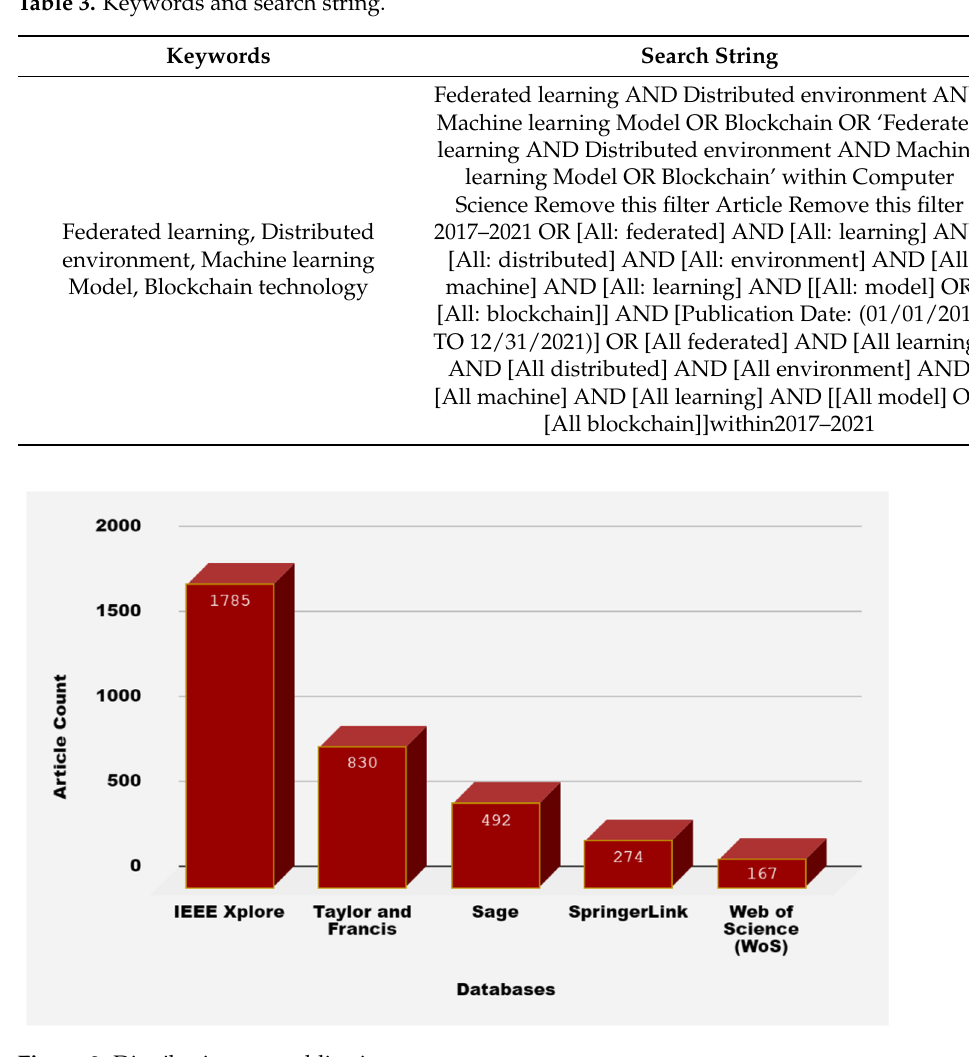
Figure 2. Distribution per publication source types.